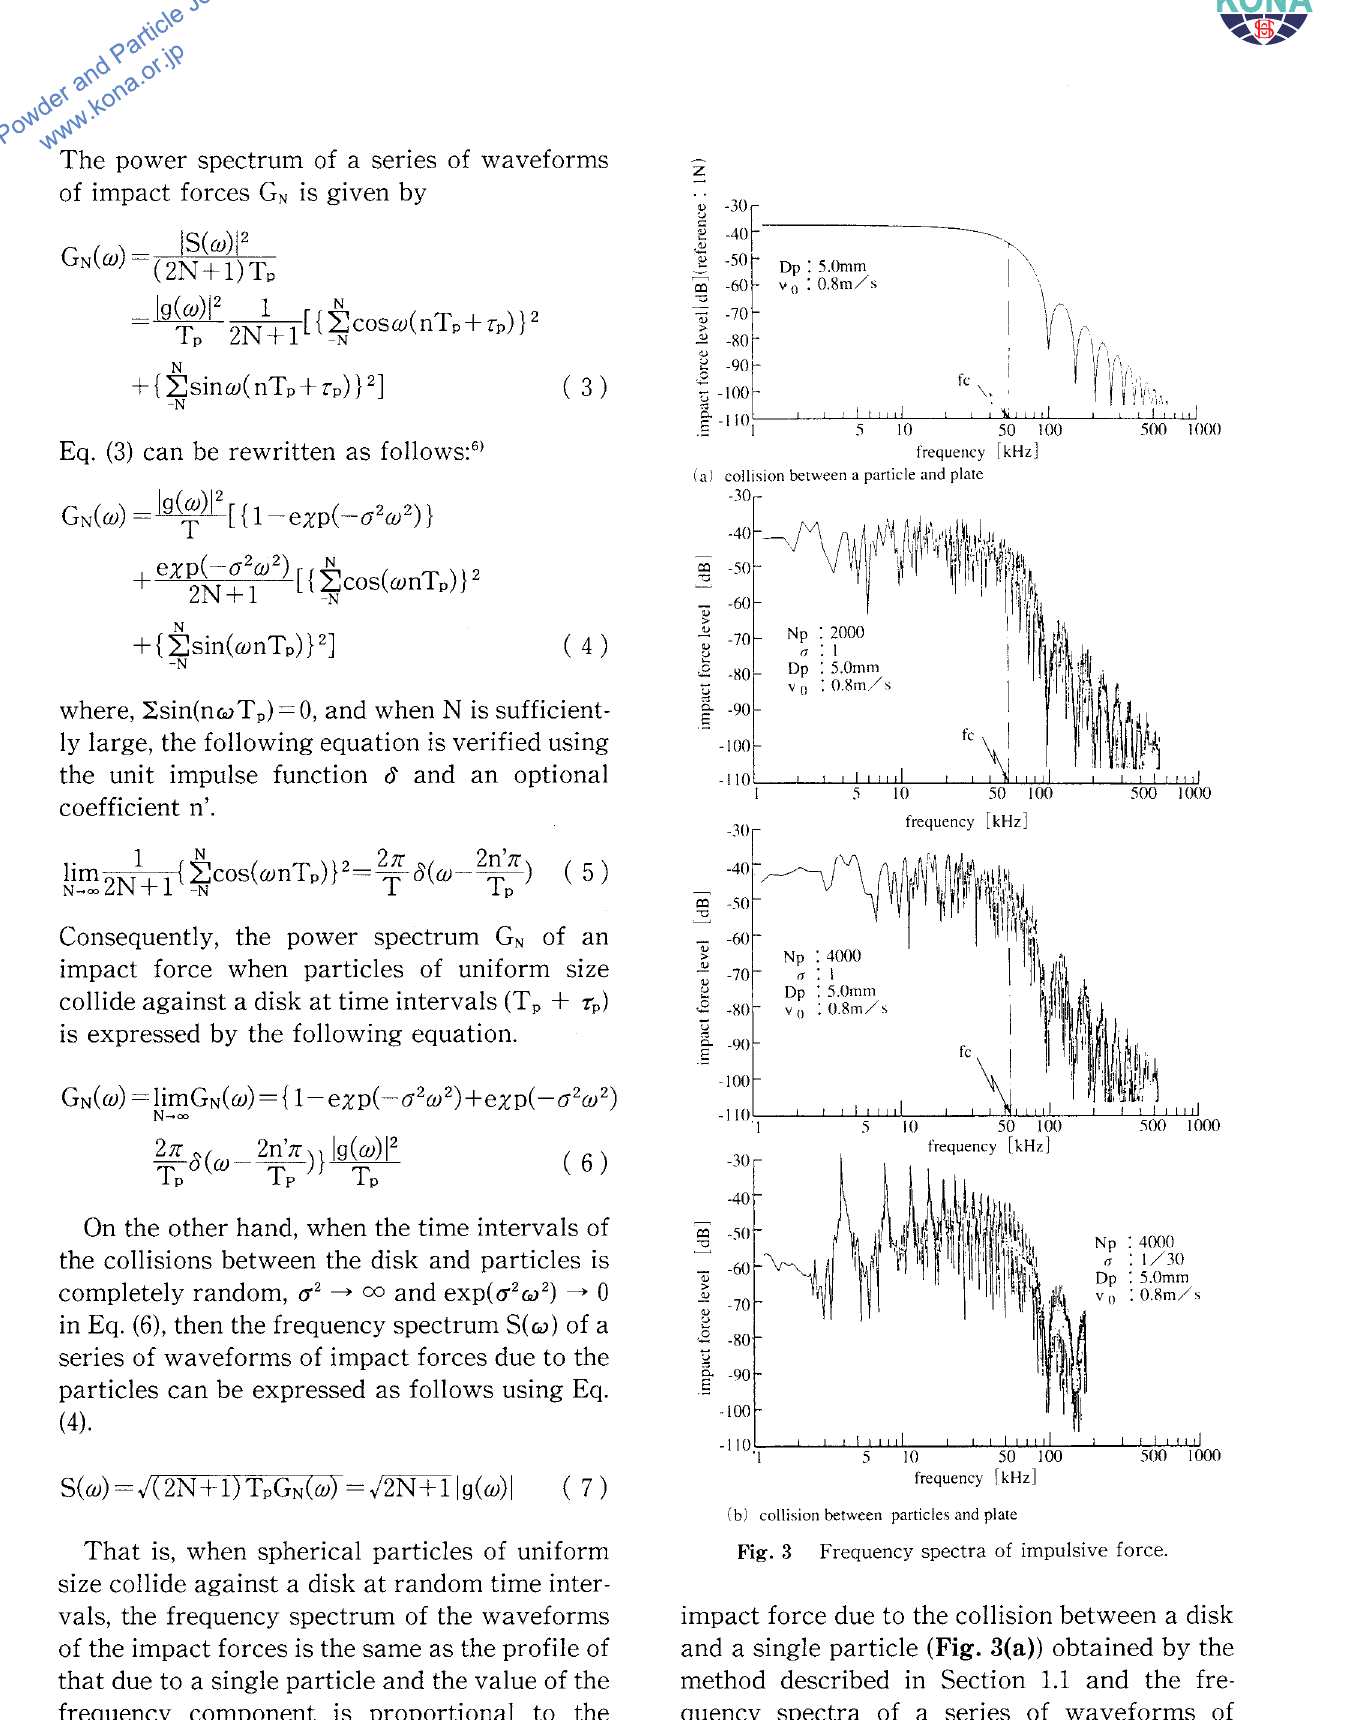
Fig. 3 Frequency spectra of impulsive force. impact force due to the collision between a disk and a single particle (Fig. 3(a)) obtained by the method described in Section 1.1 and the fre quency spectra of a series of waveforms of impact forces due to the collisions between a disk and particles of uniform size (Fig. 3(b)).